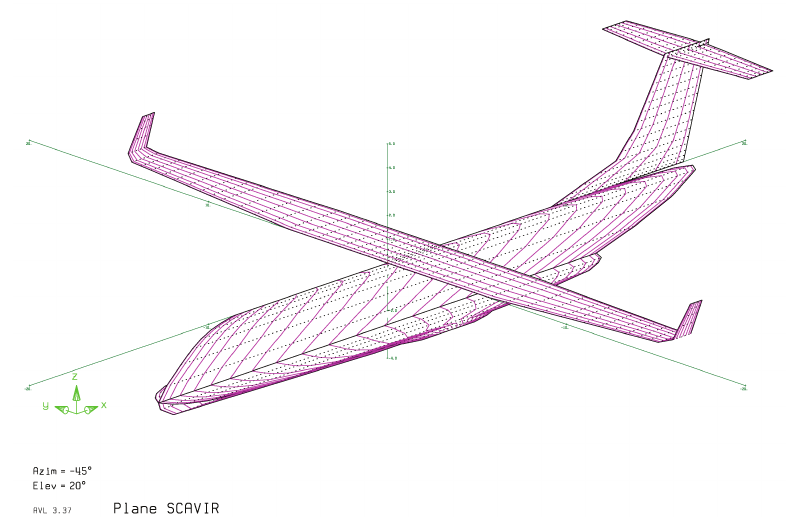
Figure 19. VLM baseline